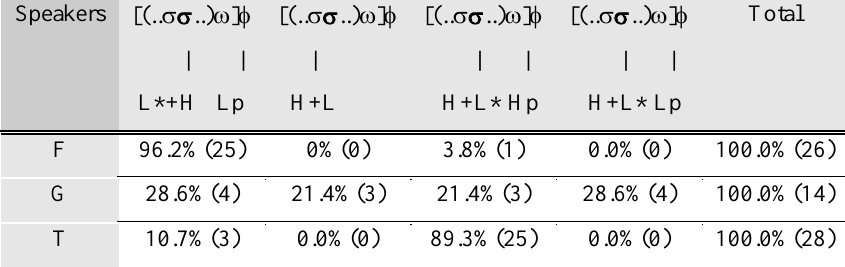
Table VI. Tonal events associated with the initial contour of the sentences with narrow-focus on the subject, in which the focused subject is formed of more than three pretonic  s (4 pretonic, 1 stressed and 1 posttonic) and in which the subject forms a non-branching 